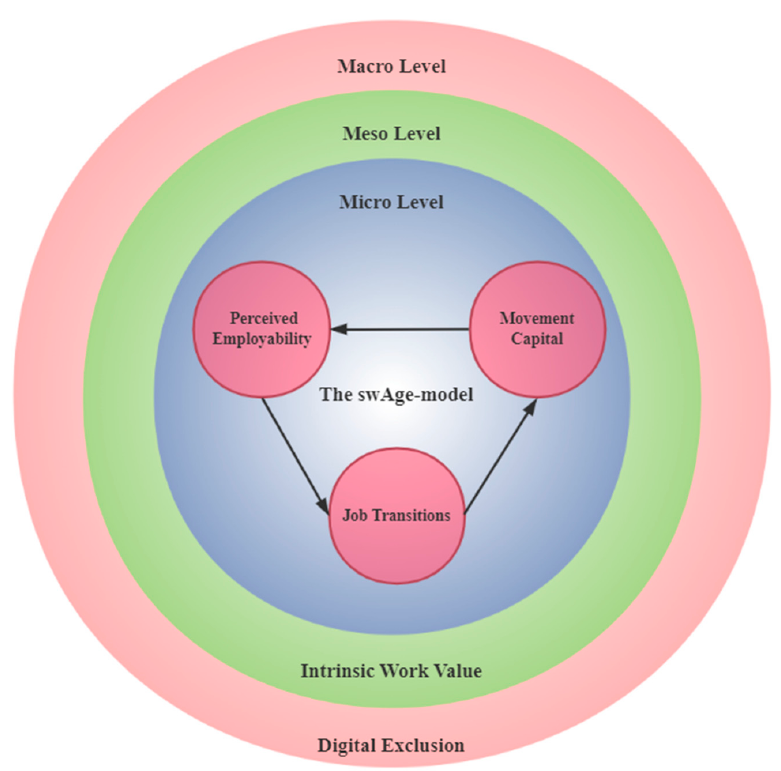
Figure 1. The dimensions of sustainable employability.